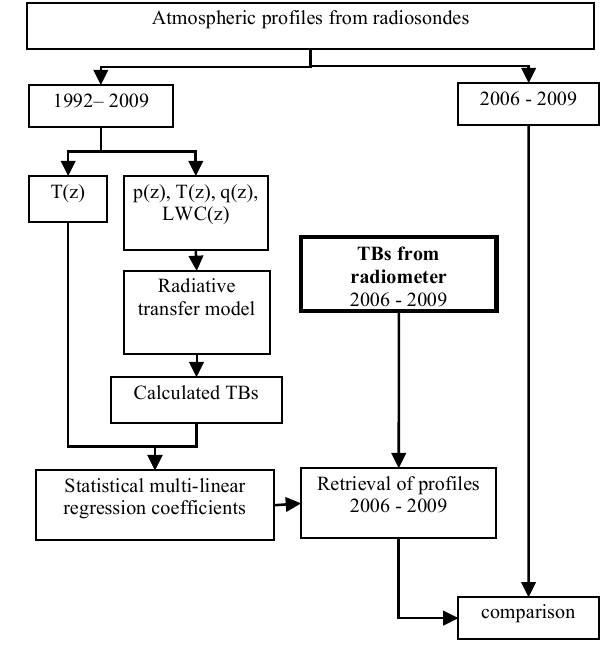
Figure 2 : Flow chart of retrieval derivation and comparisons performed in this study. Note that the 616 Fig. 2. Flow chart of retrieval derivation and comparisons per- formed in this study. Note that the following input is needed in order following input is needed in order to perform radiative transfer calculations: temperature profile T(z), 617 to perform radiative transfer calculations: temperature profile T (z) , pressure profile p(z) , humidity profile q(z) , liquid water content profile LWC( z